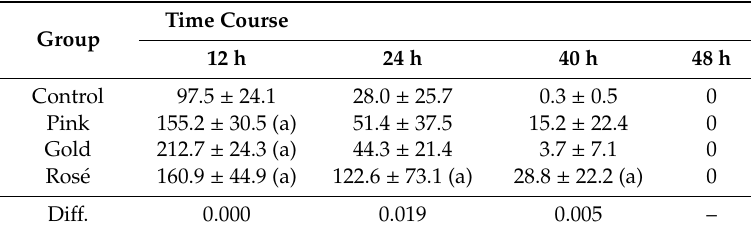
Table 3. Cell migration assay (as cell-free areas in µ m 2 xE3) results for the di ff erent groups. Time Course Group 12 h 24